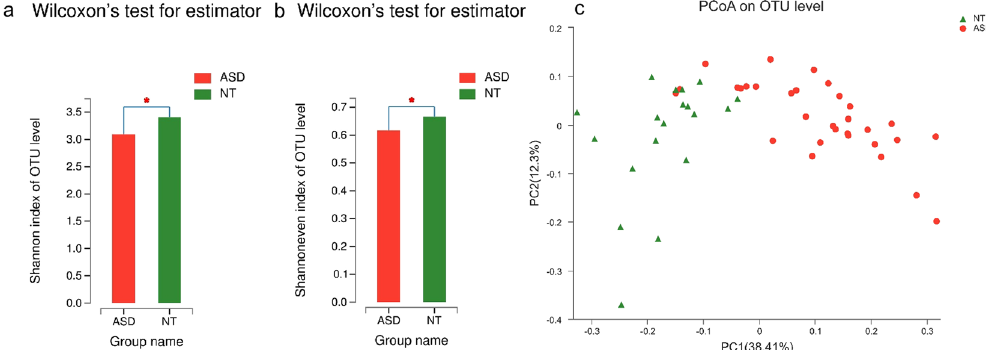
Figure 2. Gut microbiota diversity in ASD and NT subjects. ( a ) Alpha diversity based on the Shannon index of the OTU level ( b ) Alpha diversity based on the Shannoneven index of the OTU level. ( c ) PCoA of beta diversity based on the weighted UniFrac analysis of the OTU level. Autistic and neurotypical subjects are colored in red and green, respectively. * p < 0.05 vs NT group.